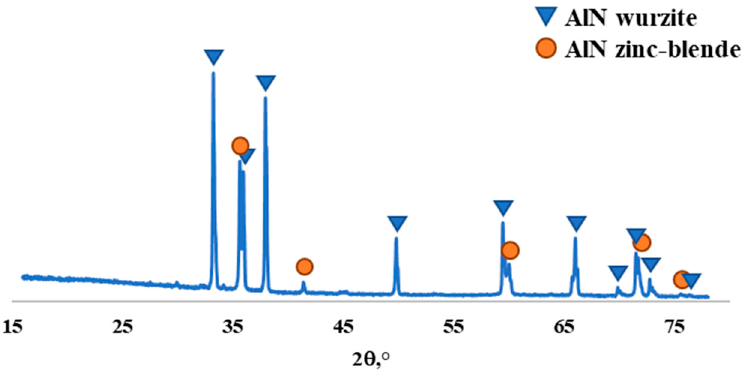
Figure 3. XRD-pattern of crystalline whiskers formed on the wall of the crucible after the sintering of SiAlON-2:0.5%NaF sample.